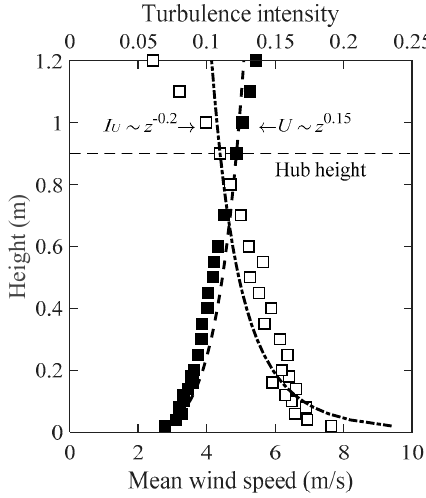
Figure 3. Experimental flow.